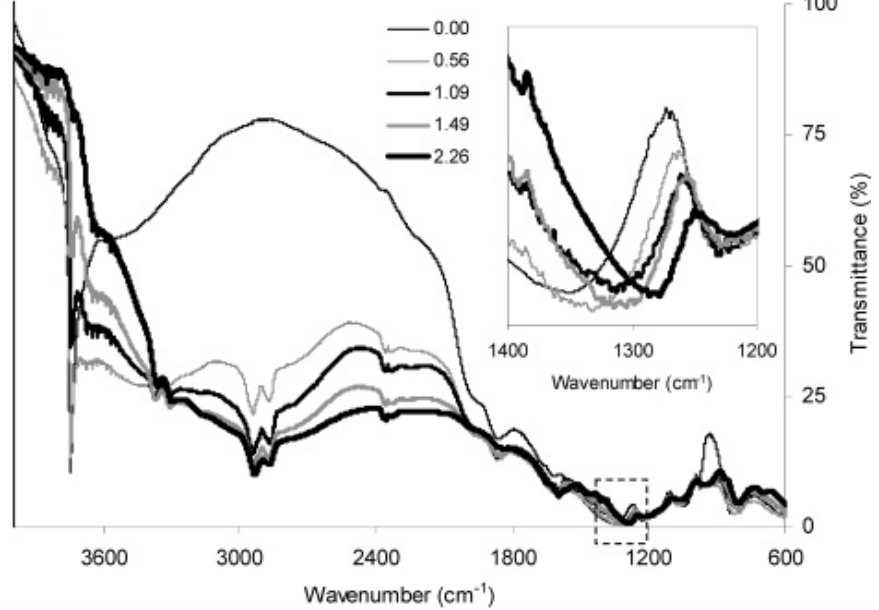
–MCM–41 with different NH 2